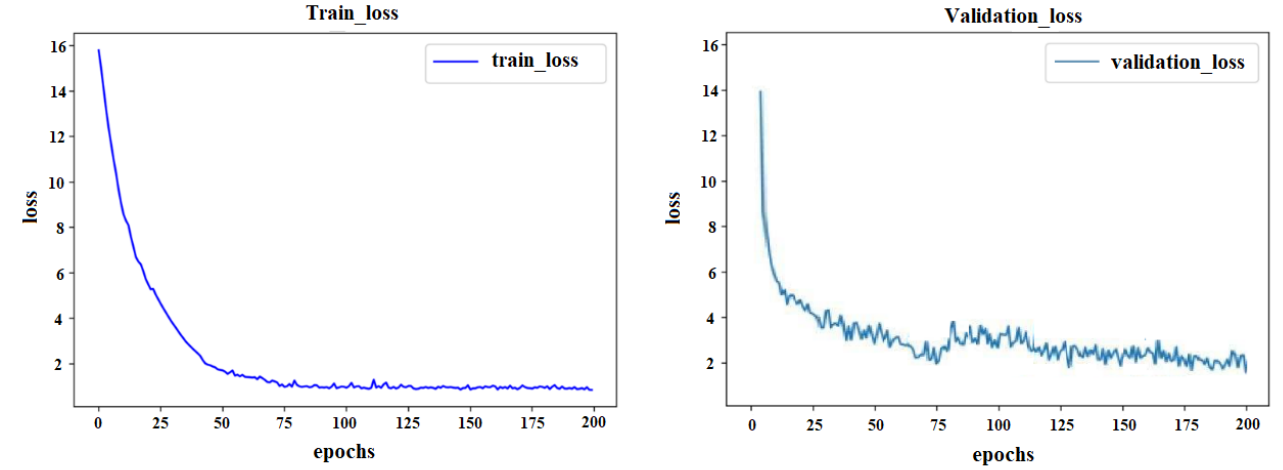
Figure 8. Loss value of the training dataset and validation